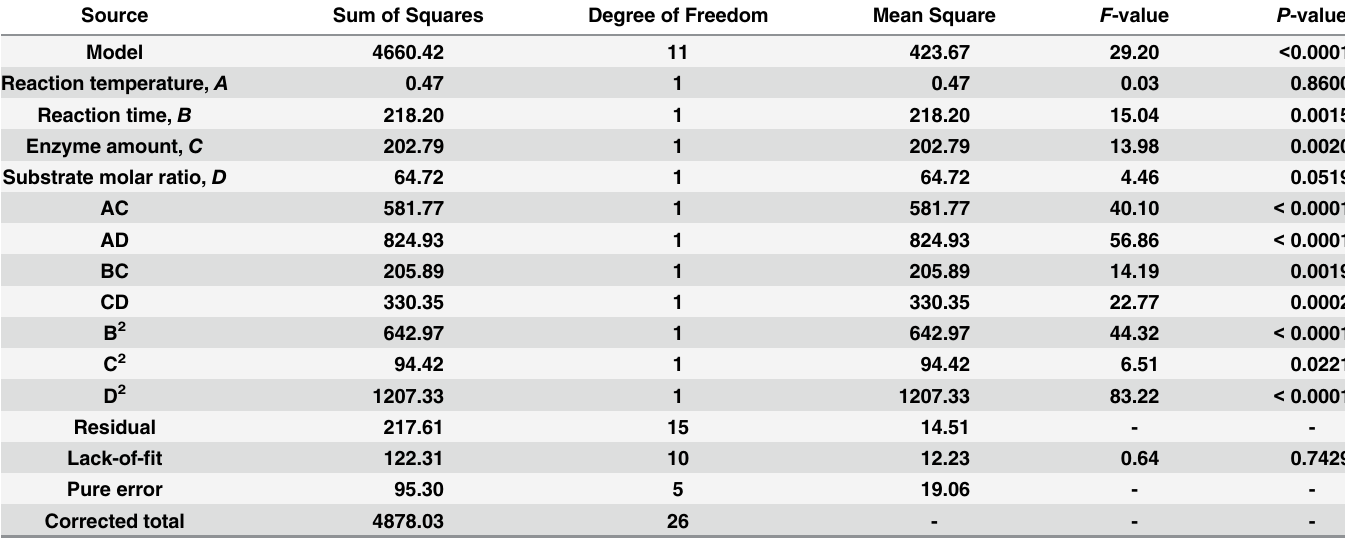
polynomial model as shown in Eq 2.